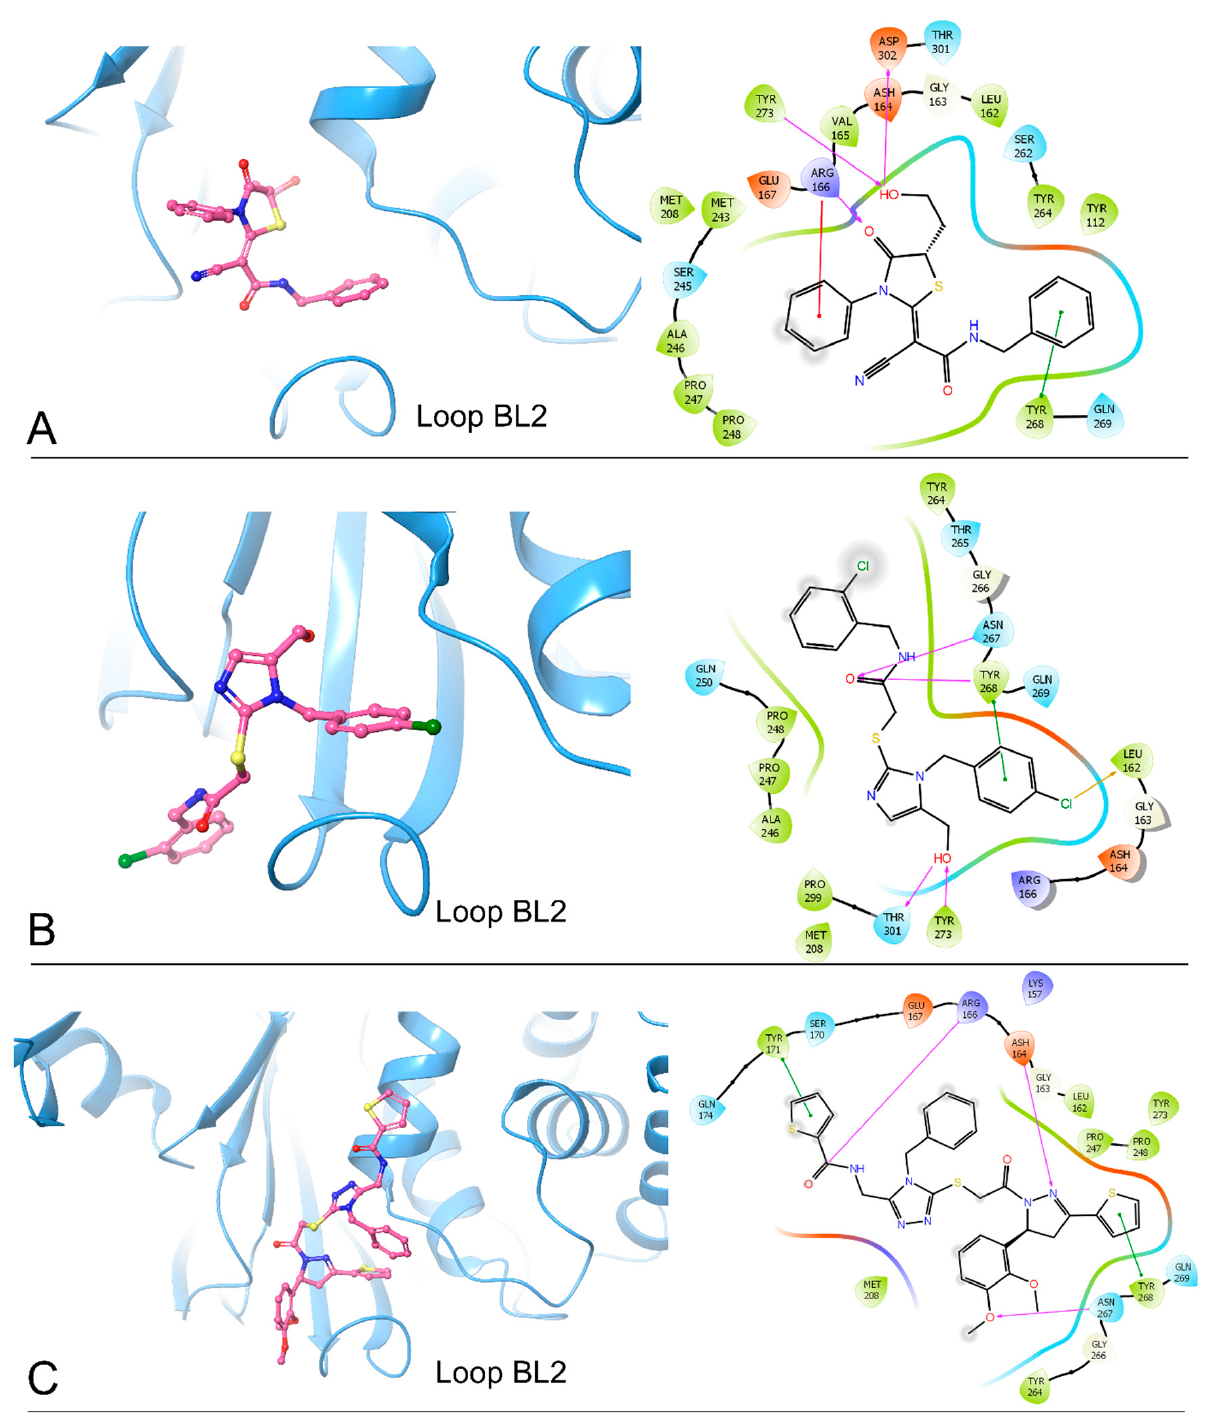
Figure 1. The docking poses and 2D ligand–protein interaction diagrams for 7LBR and the top three ligands: ( A ) F3077-0136; ( B ) F2883-0639; ( C ) F0514-5148. The pink arrow indicates the hydrogen bond; the green line represents pi–pi stacking; the red line represents pi–cation interaction; the yellow line represents the halogen bond.